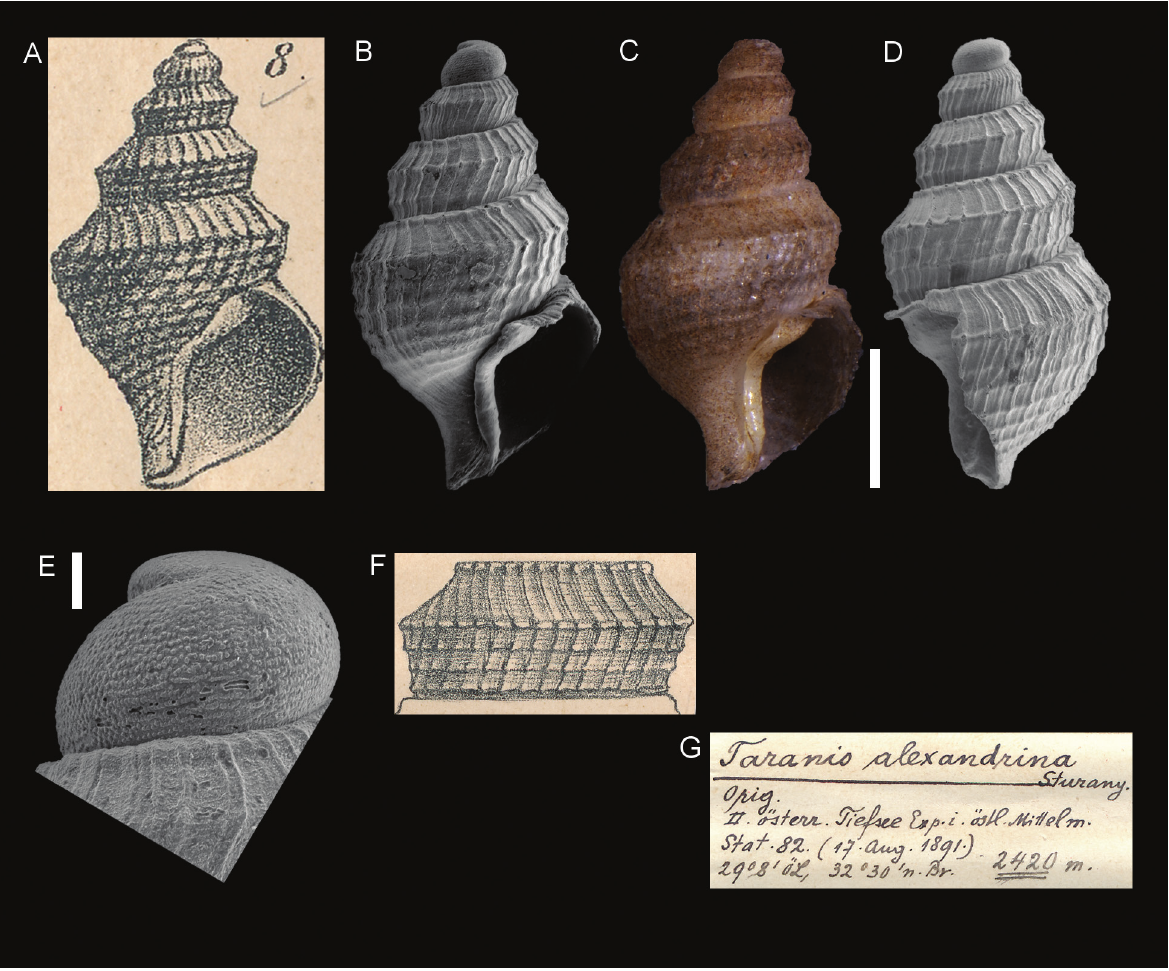
Figure 9. Taranis alexandrina, Sturany, 1896, station 82, north of Alexandria, Egypt, 2420 m. A–F . Holotype NHMW 13002: original figures in Sturany, 1896 ( A , F ), front ( B–C ) and side ( D ) views, apex ( E ). G . Original label. Scale bars: 1 mm ( B–D ); 0.1 mm ( E ).